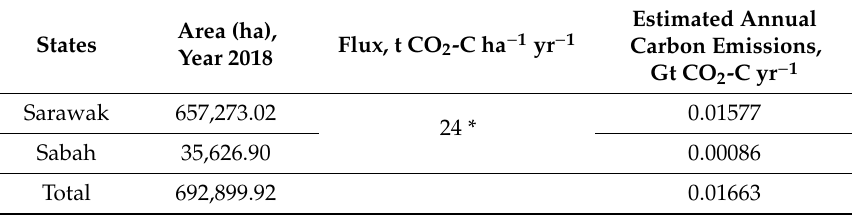
Table 9. Estimated peat soil oil palm plantation annual carbon-CO 2 emissions in Sarawak and Sabah, Malaysia.